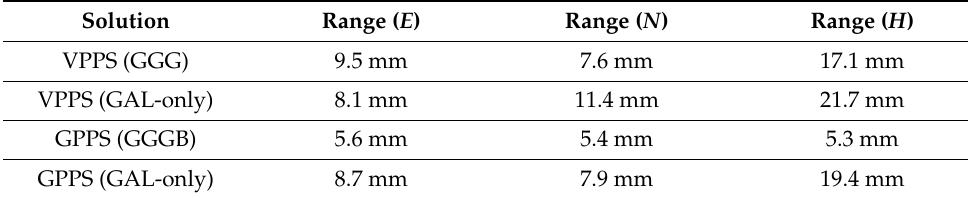
Table 5. Range values of solutions obtained with VPPS and